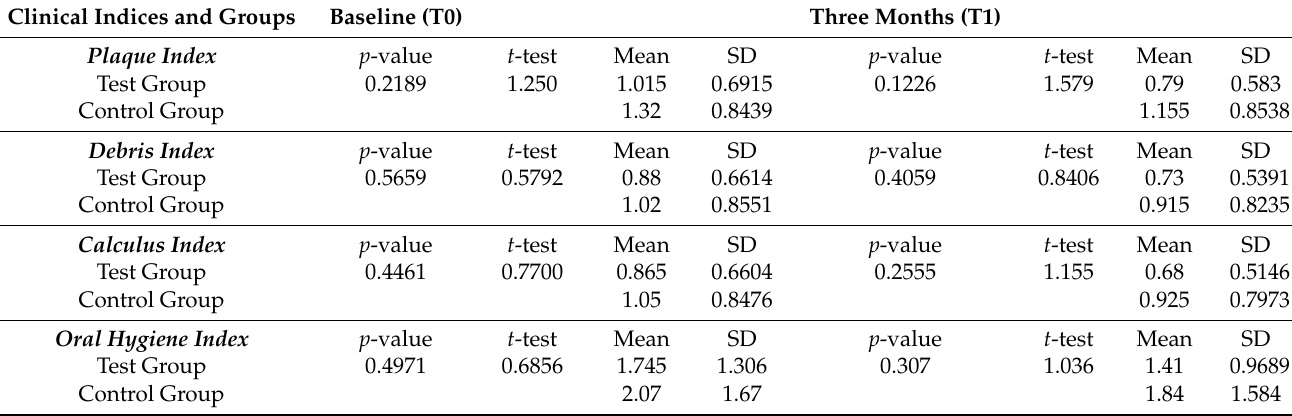
Table 1. Statistical comparison for each clinical measure in the groups at two different time points (T0–T1). Clinical Indices and